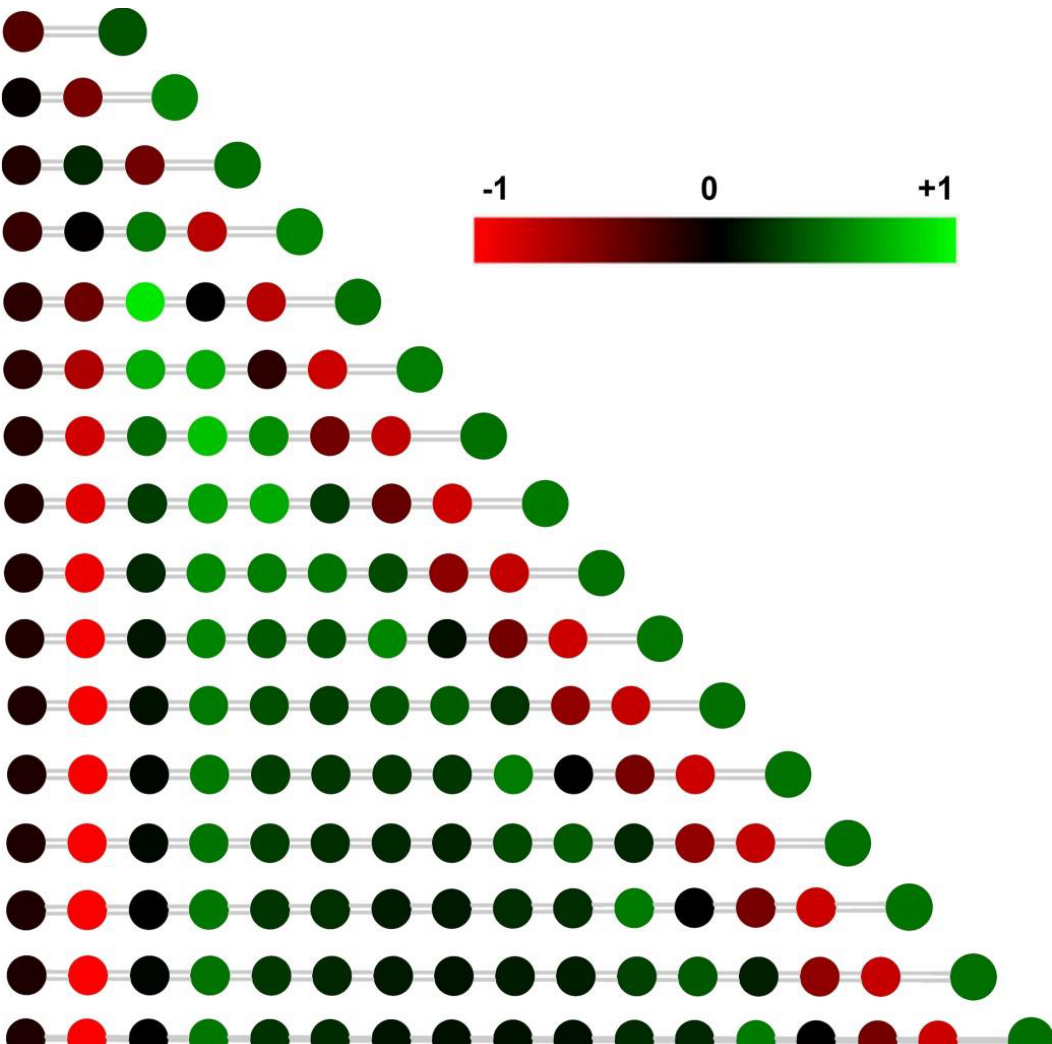
Figure 10. The NPA (natural population analysis) charge distribution for C n Sb chain clusters. The color range is depicted from − 1 to 1. The small balls and the large balls in the right end indicate carbon and antimony atoms, respectively. Table 9. The charge population and charge difference ( |∆𝐶| ) of terminal carbon atoms which are adjacent antimony (C1) and far away from antimony (C2).